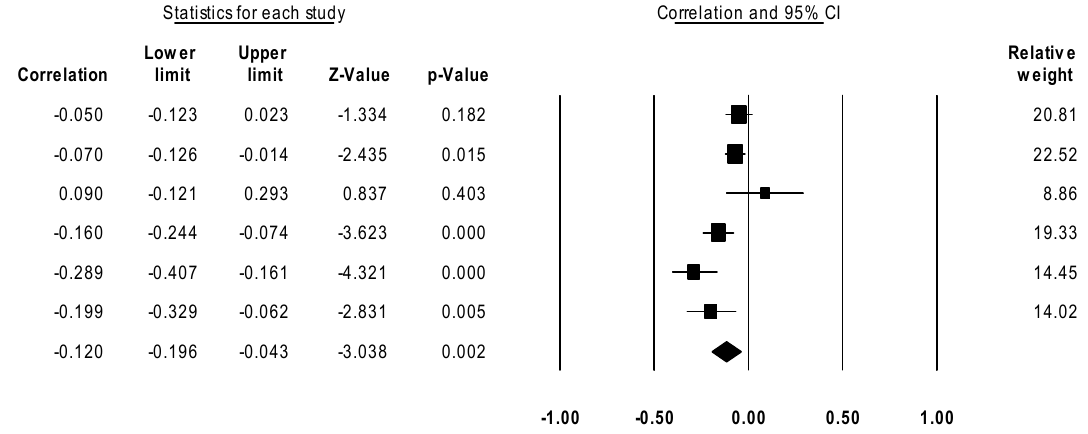
Figure 2. Random effect model for the meta-analysis of the correlation between adverse childhood experiences and psychological resilience.